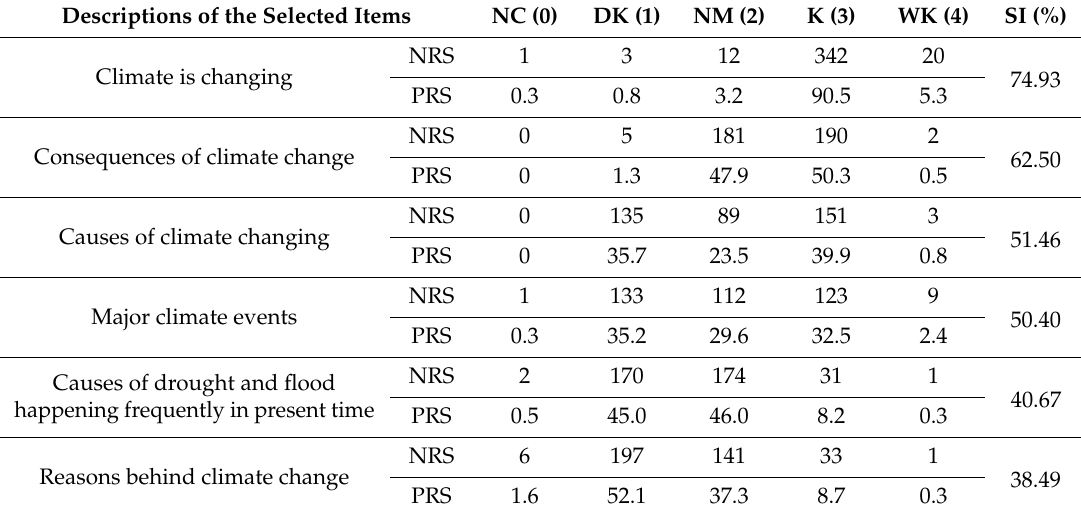
Table 2. Farmers’ knowledge about climate change